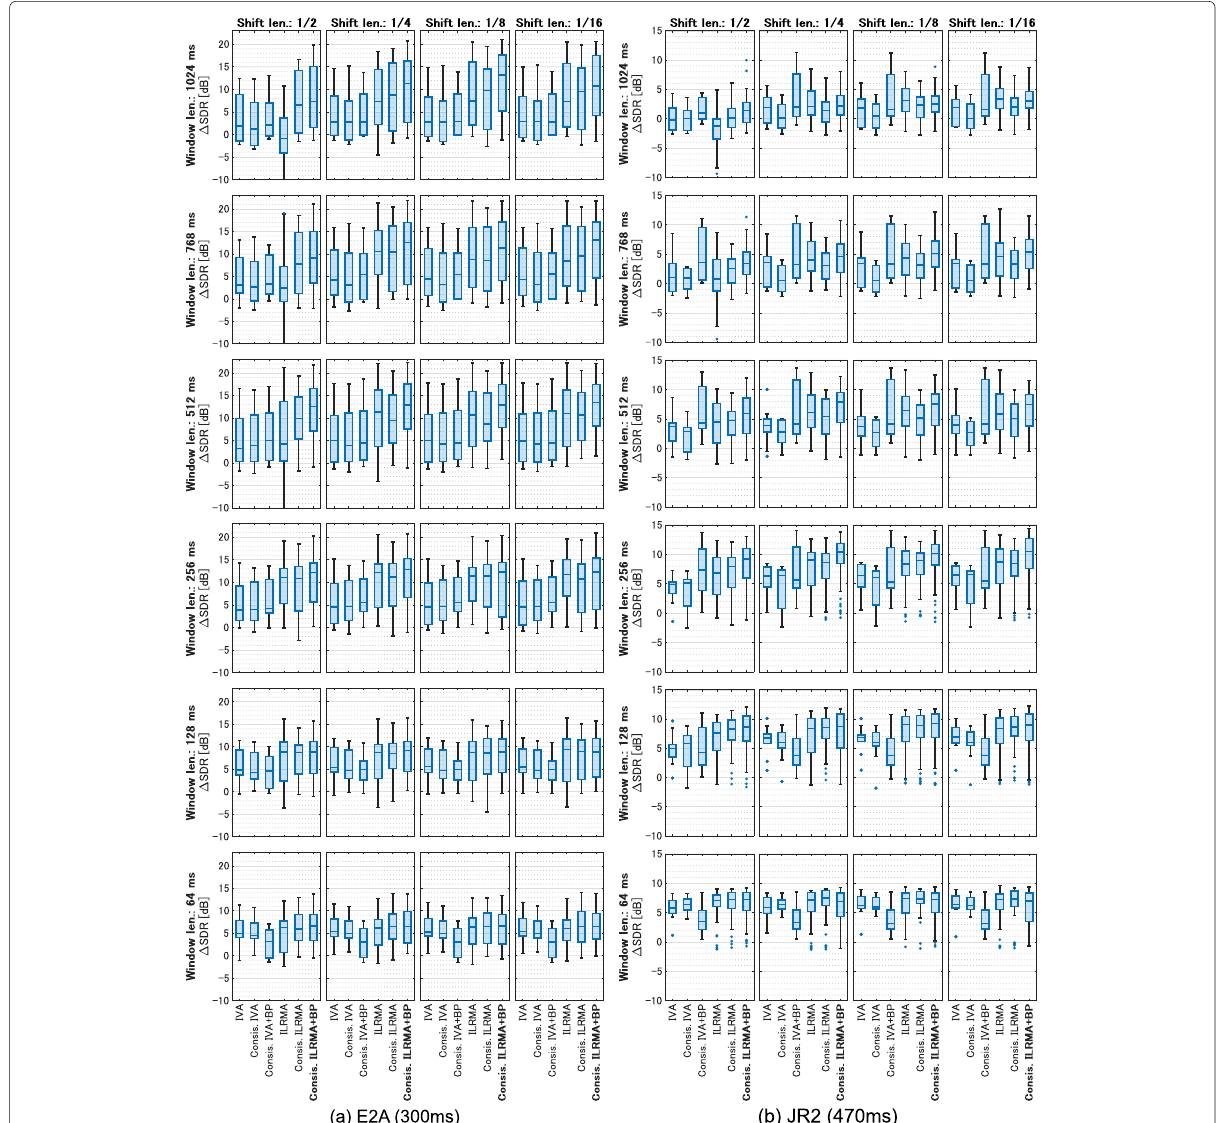
Fig. 12 Average SDR improvements for synthesized music mixtures (music 1–10) with a E2A and b JR2 , where Hamming window is used in